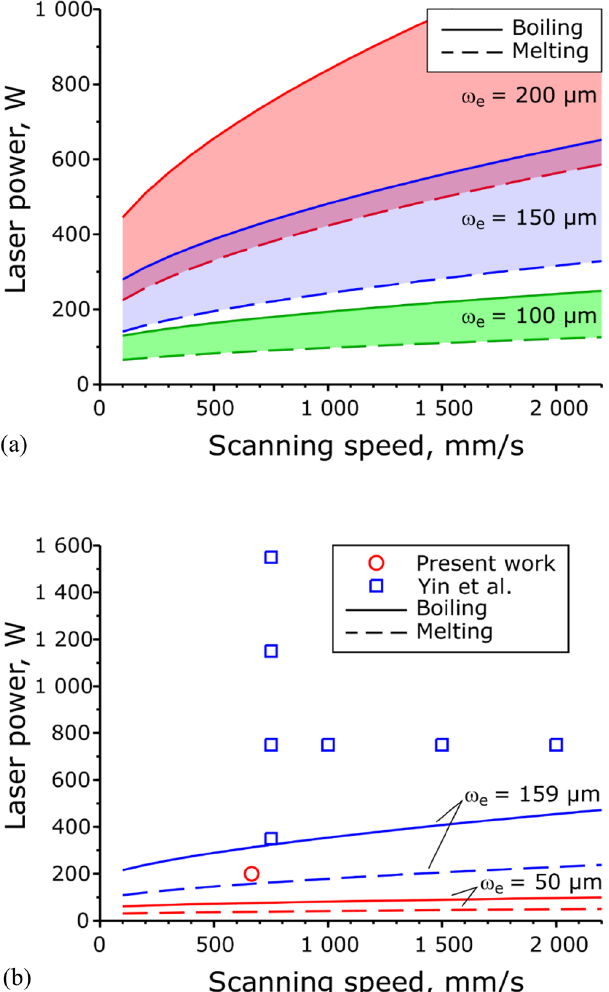
Figure 8. Scanning speed–laser power process map of the Inconel 718 alloy. The radius of the laser spot size is 100–200 µm. ( a ) Process window without boiling the melt pool. ( b ) Process window and fabrication condition in the